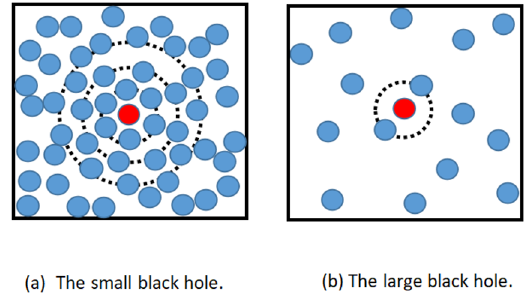
Figure 6 . Sketches of the mesoscopic structures for the charged AdS black holes. (a) The mesoscopic structure of the small black hole behaves as the liquid. (b) The mesoscopic structure of the large black hole behaves as the